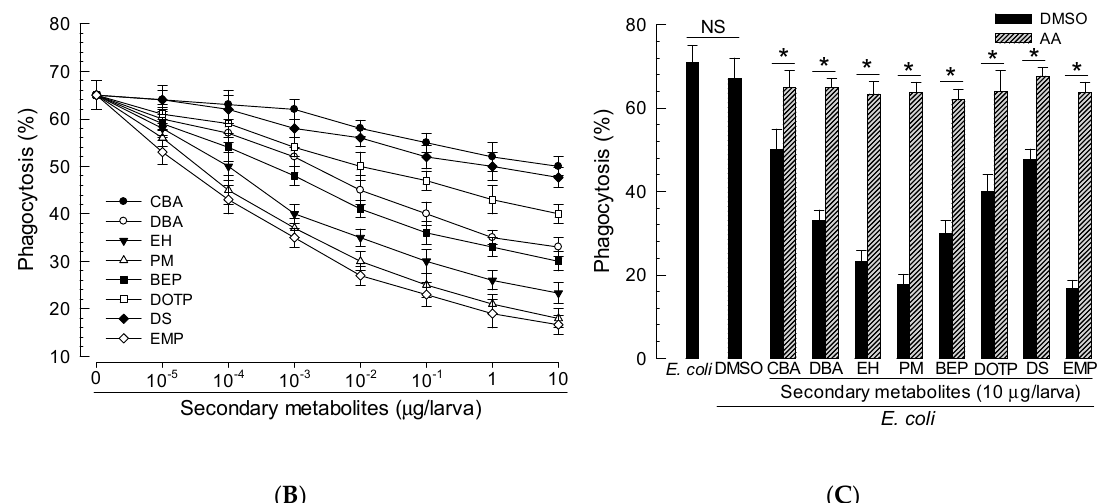
Figure 5. Immunosuppressive activities of eight PLA 2 inhibitors against hemocyte phagocytosis of S. exigua . The eight compounds are bis(2-ethylhexyl) phthalate (BEP), o-cyanobenzoic acid (CBA), dibutylamine (DBA), dioctyl terephthalate (DOTP), docosane (DS), 2-ethyl-1-hexanol (EH), 3-ethoxy-4-methoxyphenol (EMP), and phthalimide (PM). ( A ) Inhibition of phagocytosis by the inhibitor treatments at 10 µg/larva. Phagocytic cells are recognized by green color emitted by FITC-labeled E. coli . Control (CON) used dimethyl sulfoxide (DMSO) for solvent control. ( B ) Dose effects of the inhibitors on suppressing phagocytosis. ( C ) Rescue effects of arachidonic acid (AA’, 10 µg/larva) on the phagocytosis suppressed by the inhibitors. Each treatment was replicated three times with independent insect samples. Asterisks above standard deviation bars indicate significant differences between treatments at Type I error = 0.05 (LSD test). ‘NS’ stands for no significant difference. Table 2. Immunosuppressive activities of eight compounds identified from X. hominickii culture broth.